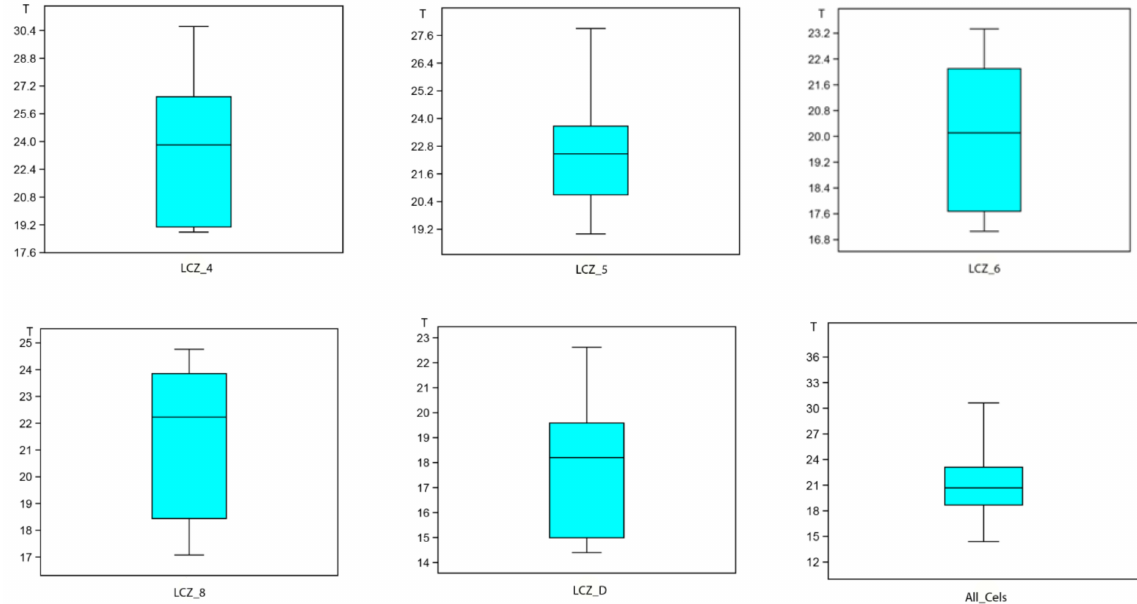
Figure 3. Box-Plot diagrams for the surveyed LST in the five largest LCZs and for all LCZs. (Note the differences in